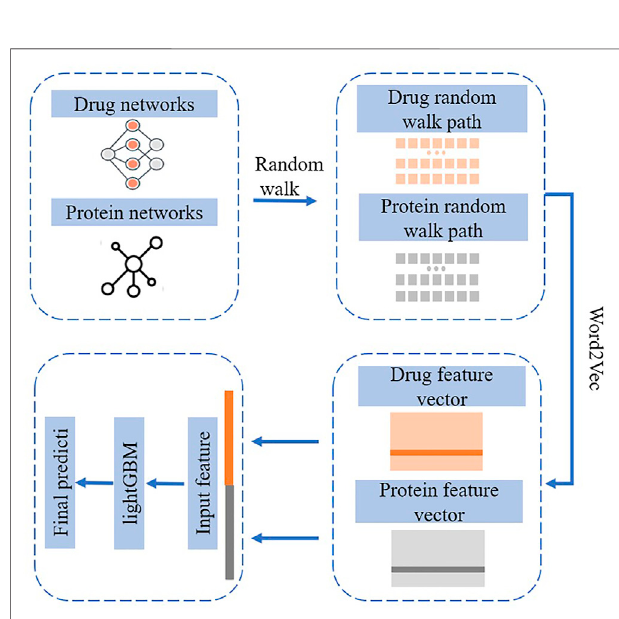
FIGURE 3 | Flowchart of graph embedding-based algorithm NEDTP.